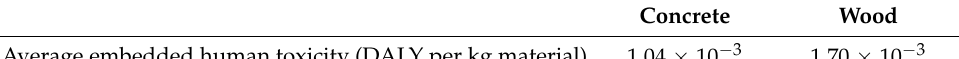
Table 5. Comparison of the average embedded toxicity in DALY per kg material and the embodied tox- icity (toxicological footprint) in DALY per kg material given as a toxicity ratio (Embodied:Embedded). Concrete Wood Average embedded human toxicity (DALY per kg material) 1.04 × 10 − 3 1.70 × 10 − 3 Embodied human toxicity (DALY per kg material) 1.98 × 10 − 3